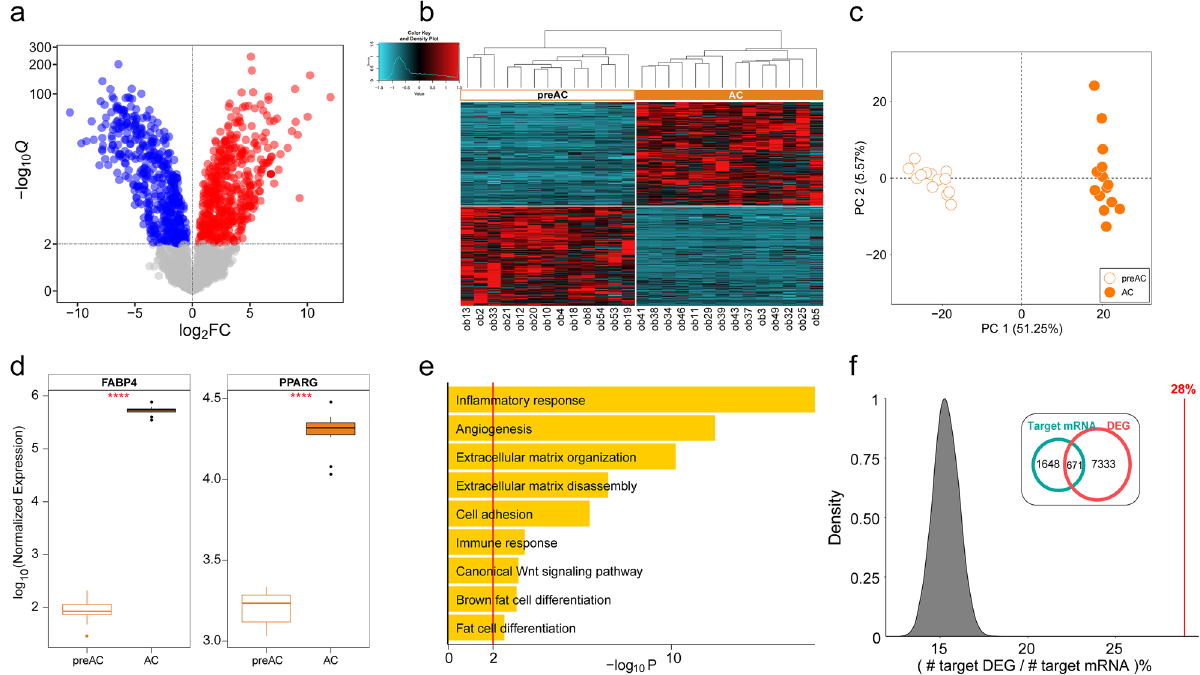
Figure 1. Detection of miRNAs controlling adipogenesis. ( a ) Volcano plot representing the differential expression of miRNAs in ACs compared to preACs. − log 10 Q values (Y-axis) were plotted against log 2 FC values (X-axis). Significantly upregulated miRNAs ( Q -values < 0.01, FC > 0) are shown as red points, while significantly downregulated miRNAs ( Q -values < 0.01, FC < 0) are shown as blue points. ( b ) Heatmap depicting patterns of Z score scaled expression for DEMs along with unsupervised hierarchical clustering. The rows of the heatmap are the 929 DEMs were selected according to the threshold, Q -value < 0.01, sorted by unsupervised hierarchical clustering based on their gene expression profiles. The columns of the heatmap are the 13 preACs and 14 ACs, also sorted by unsupervised hierarchical clustering based on their gene expression profiles. ( c ) PCA of DEMs obtained from preAC and AC samples. DEMs selected according to the threshold, Q -value < 0.01, were used. ( d ) Boxplots illustrating the expression levels of the adipogenesis marker genes FABP4 and PPARG . The DESeq2- normalized count of each gene was used as the expression level. ‘****’ denotes P value < 0.0001, DESeq2. ( e ) GO analysis of DEGs targeted by DEMs with Q -value < 0.01. The top GO (biological process) terms significantly enriched are shown in the bar graph. – log 10 P (X-axis) against each functional term (Y-axis) are depicted as yellow bars, and the red line annotates significance at a P value of 0.01 (− log 10 P = 2). ( f ) Distribution of the percentages (the number of DEGs in the DEM target genes) estimated during 10,000 random permutations and (inset) Venn diagram showing the number of DEM target genes and DEGs. For each permutation, 2319 genes (the number of DEM target genes) were randomly selected from all protein-coding genes, and the percentage of DEGs in the randomly selected genes was calculated. The red line indicates the observed percentage of DEGs in the miRNA target genes